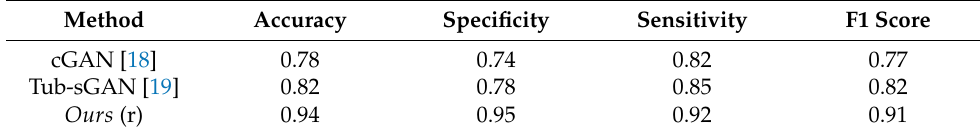
Table 5. Evaluation for DME occurrence prediction.